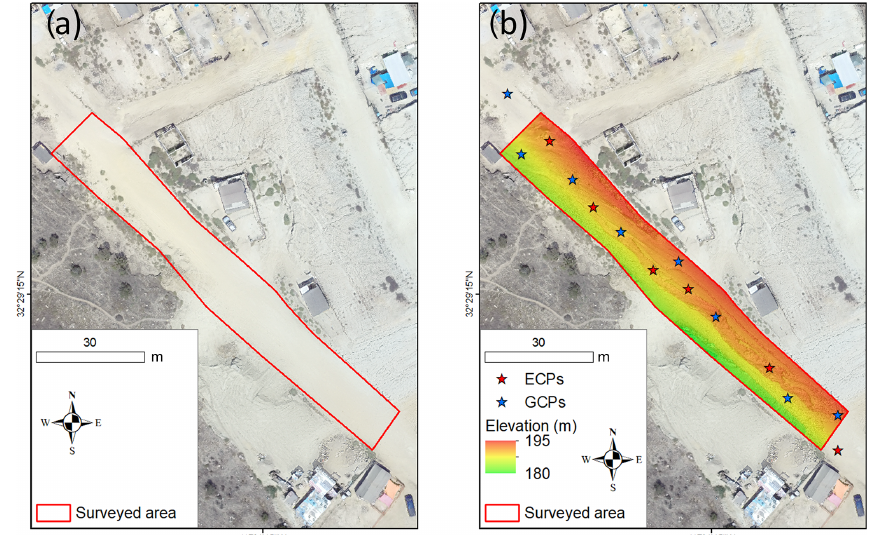
Figure 4. Mega-gully A formed on 15 September 2015 by WRIF: (a) orthophoto acquired before the WRIF showing the extent of the surveyed area centered on the red rectangle and (b) the resulting DSM showing the spatial distribution of ground control points and error control points (GCPs and ECPs,